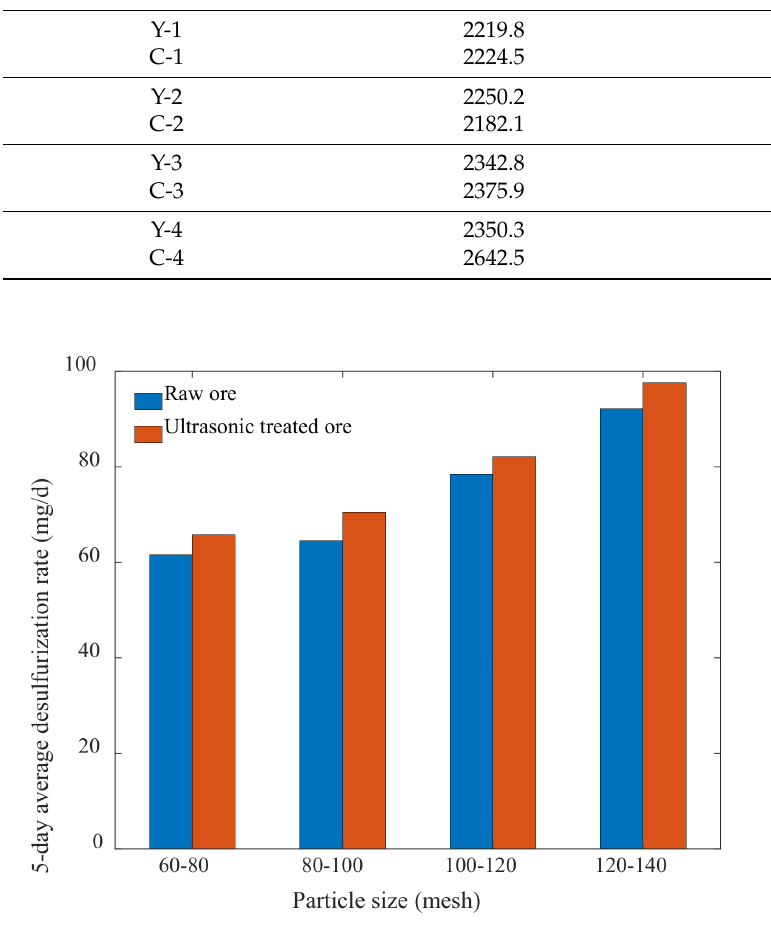
Figure 6. Comparison of the 5–day average desulfurization rates of different particle